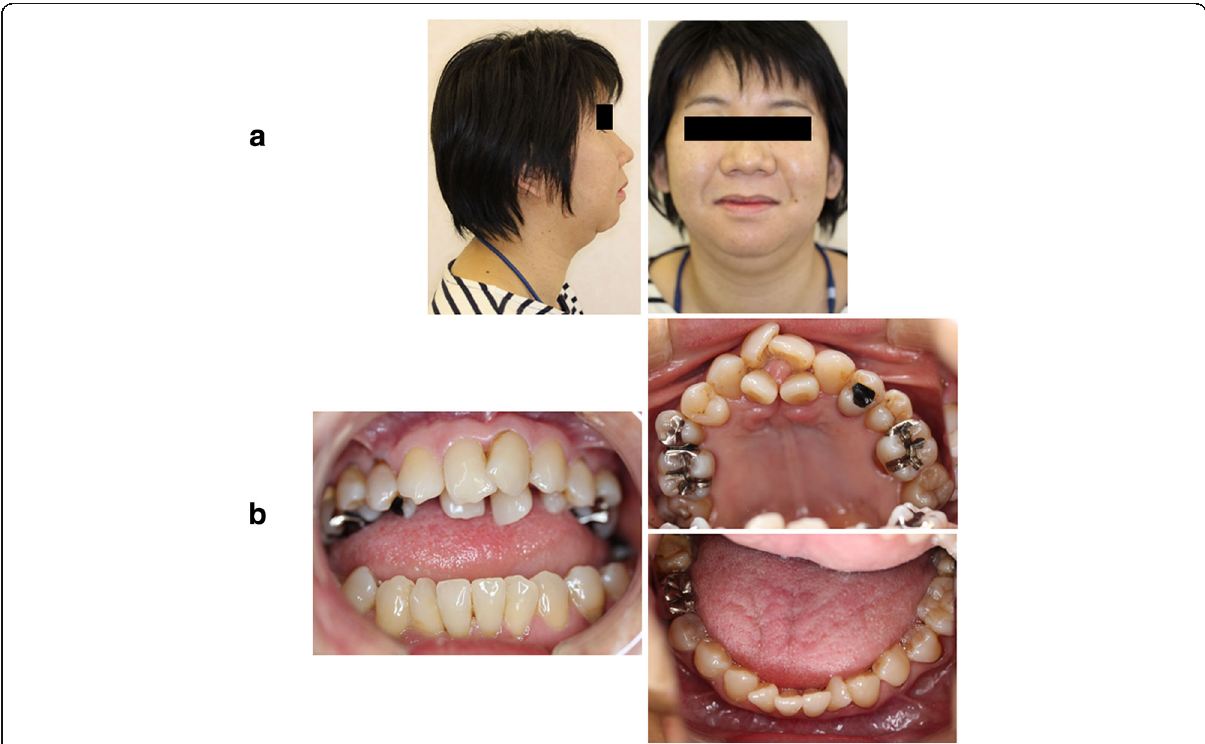
Fig. 1 Patient imaging data. a Photographs from extraoral examination reveal mandibular hypoplasia but no asymmetry. b Photographs from intraoral examination reveal an anterior open bite (inter-incisor distance: 23 mm) and early contact of the second molars. The upper teeth